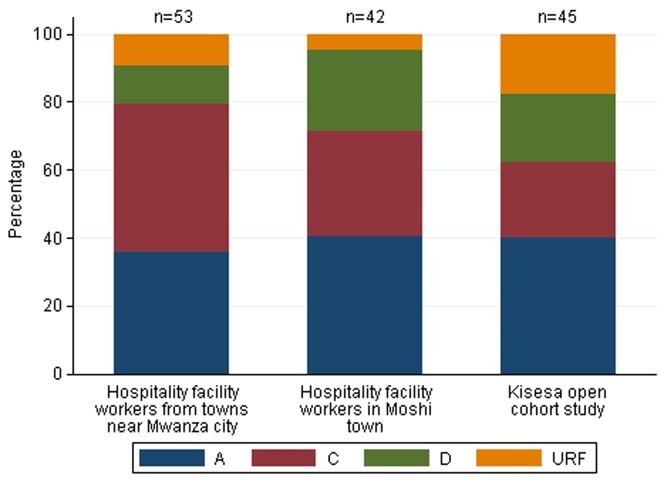
Distribution of HIV-1 subtype by cohort.Χ2 test, p = 0.16.